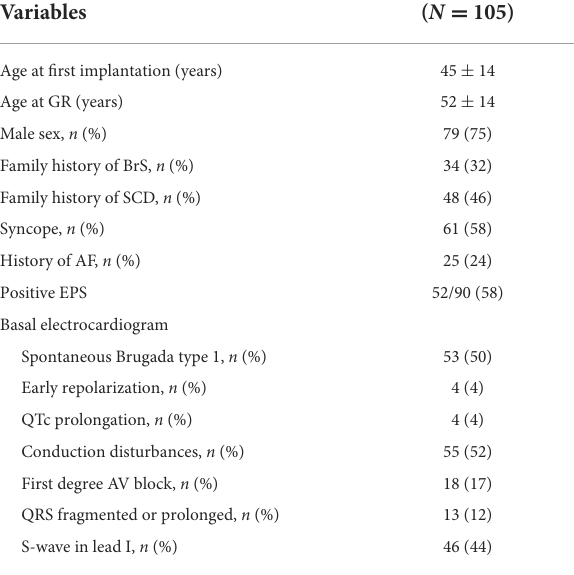
TABLE 1 Clinical and electrocardiographic characteristics of the study